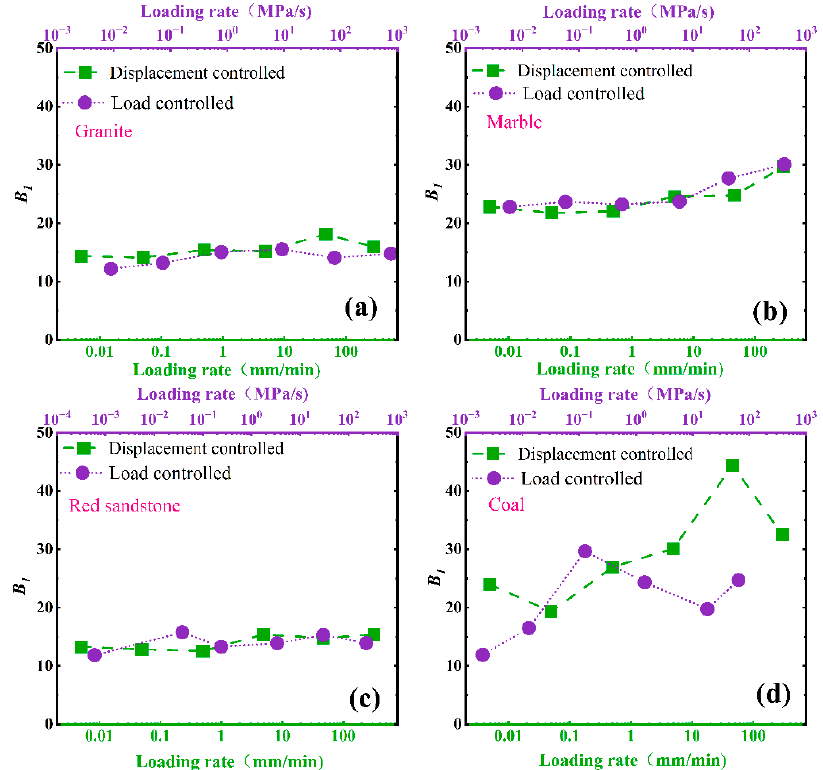
Figure 6. Effect of loading mode on B 1: ( a ) granite, ( b ) marble, ( c ) red sandstone, ( d ) coal.